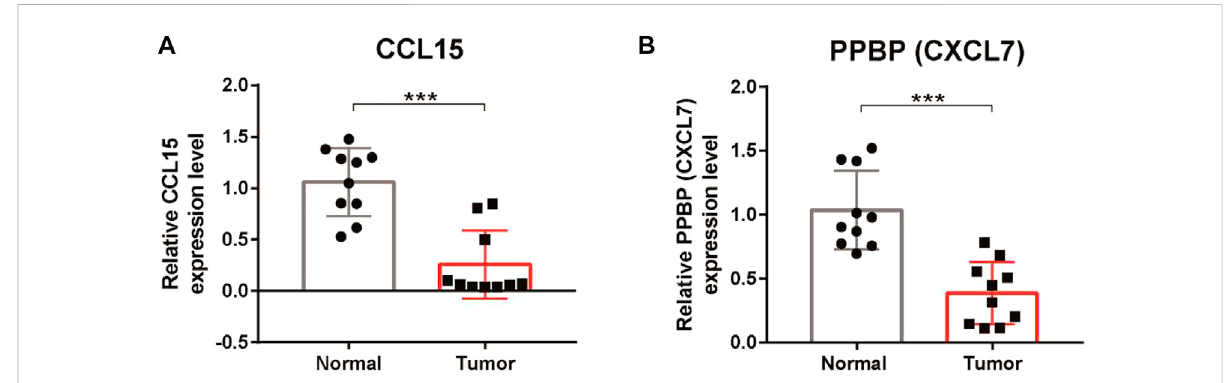
FIGURE 10 Veri fi cation of the expression of CCL15 and PPBP in LUSC tissues. (A) qRT ‒ PCR analysis of the relative mRNA levels of CCL15 in tumor tissues compared with adjacent normal tissues. (B) qRT ‒ PCR analysis of the relative mRNA levels of PPBP in tumor tissues compared with adjacent